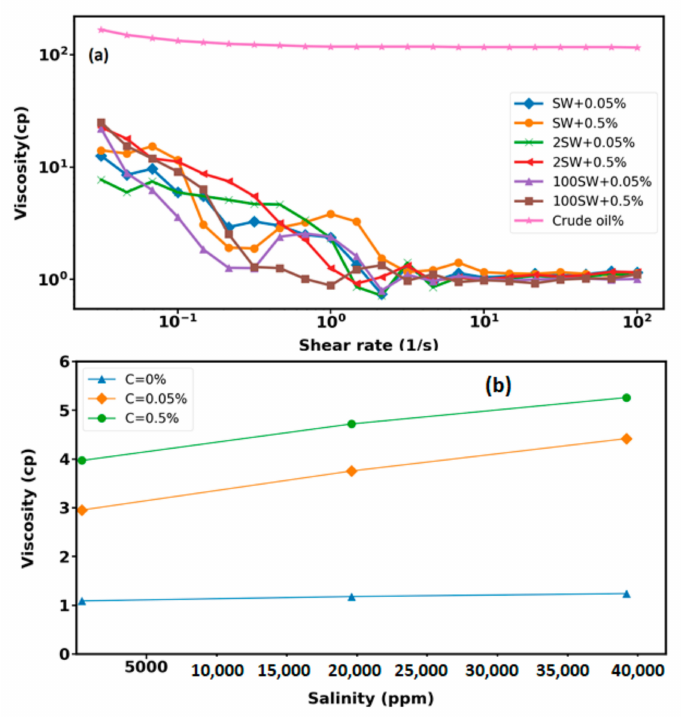
Figure 9. ( a ) Dynamic viscosity of the iron-carbon nanohybrid and the crude oil as a function of shear rate. ( b ) Average viscosity variations with nanoparticle concentration and base fluid salinity at ambient